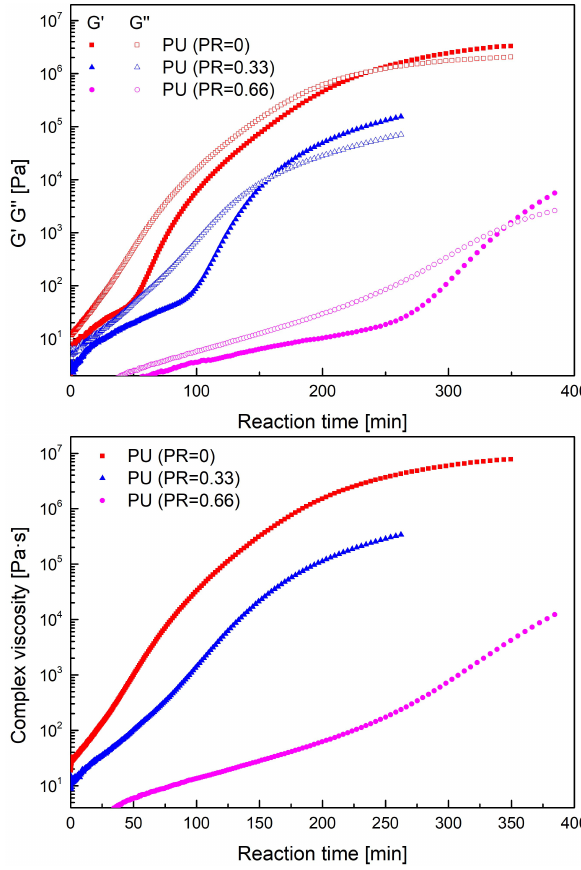
Figure 3: Time sweep results for storage and loss modulus G ′ and G ′′ (left) as well as complex viscosity (right) for polyurethanes with PR of 0, 0.33, 0.66 without